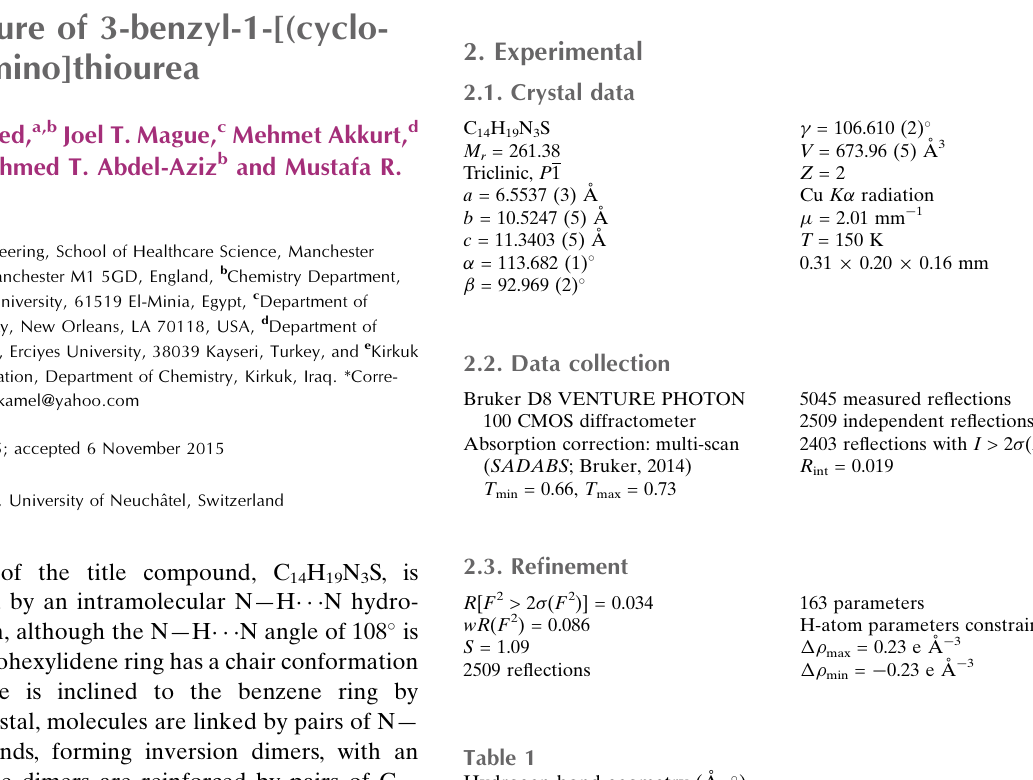
Hydrogen-bond geometry (A˚ , (cid:3)